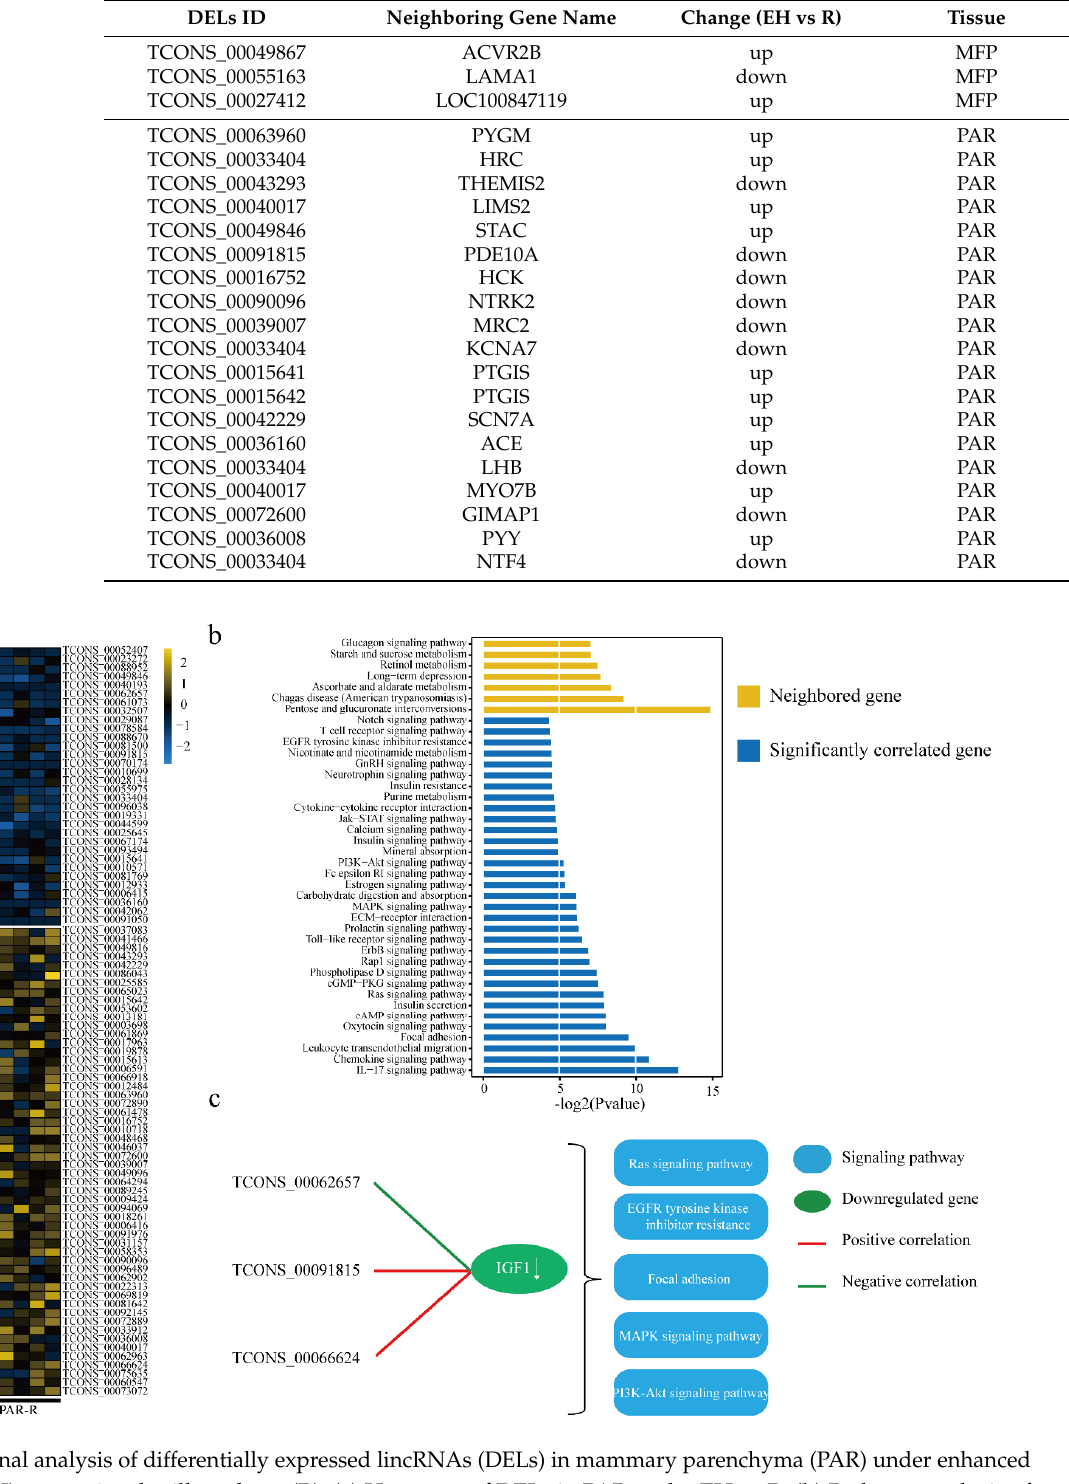
Table 1. Differentially expressed lincRNAs’ (DELs’) neighbored DEGs in PAR and MFP.